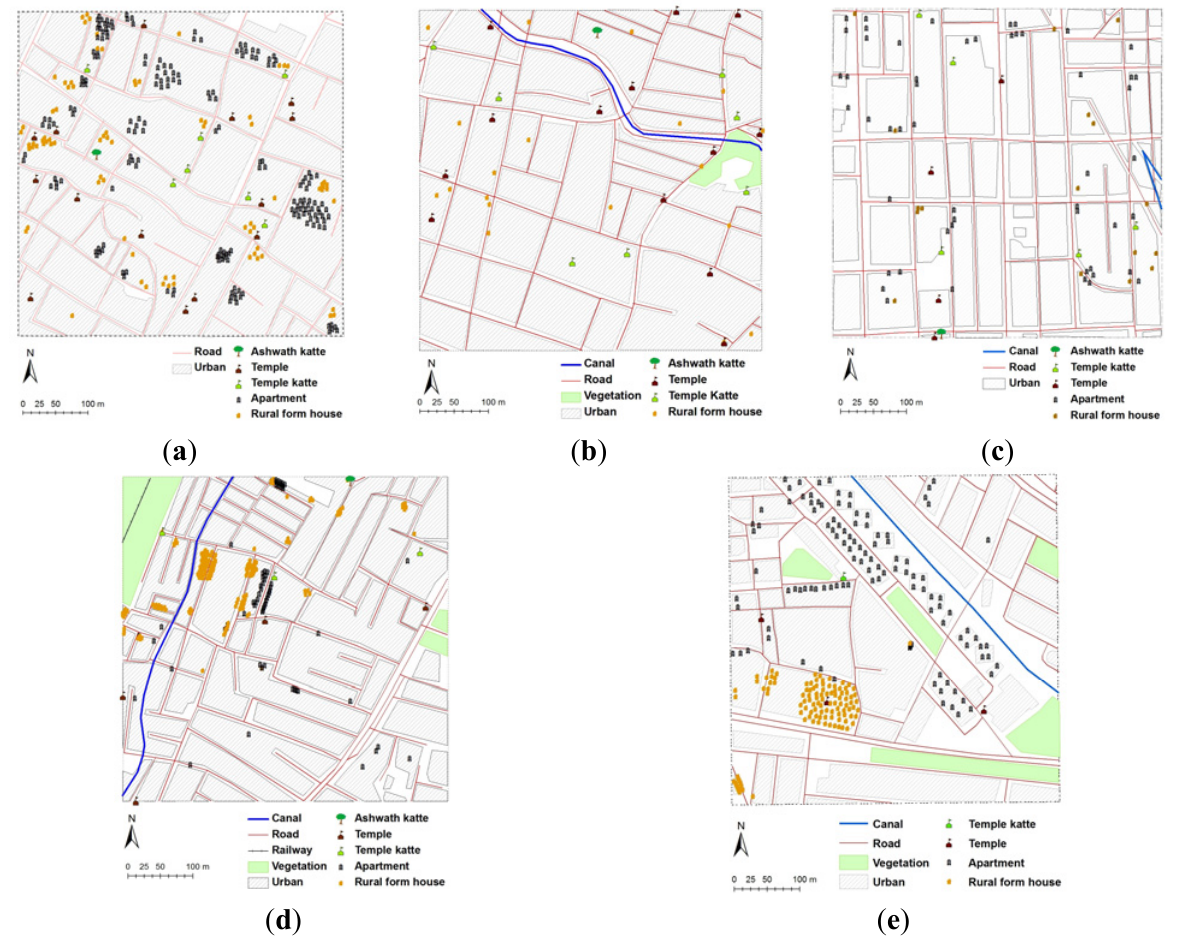
Figure 11. Distribution of indicators of rurality in the five study locations in Bangalore, based on field surveys. ( a ) Avenue Road; ( b ) Commercial Street; ( c ) Malleswaram; ( d ) Kacharakanahalli; ( e )